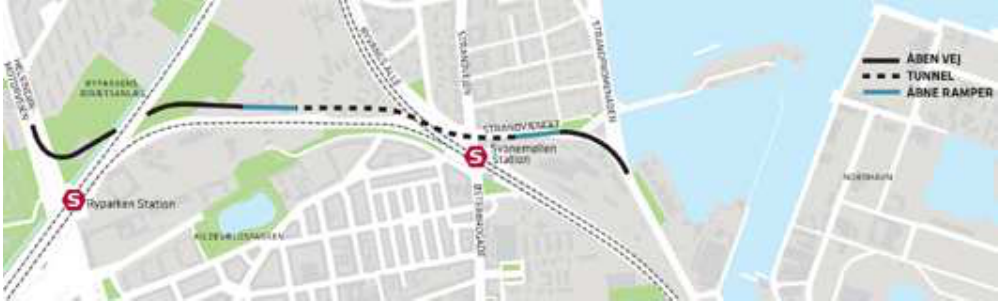
Figure 4. The proposed new Nordhavnsvej link in Copenhagen. Legend: Black line: surface road; black dotted line: road tunnel; blue line: surface ramps. Source: Municipality of Copenhagen